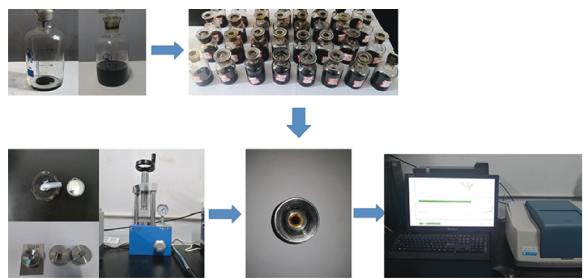
Figure 1: Fourier infrared spectroscopy (FTIR) sample preparation and Table 4: Influence of matrix asphalt on three indexes before and after mixing and aging.